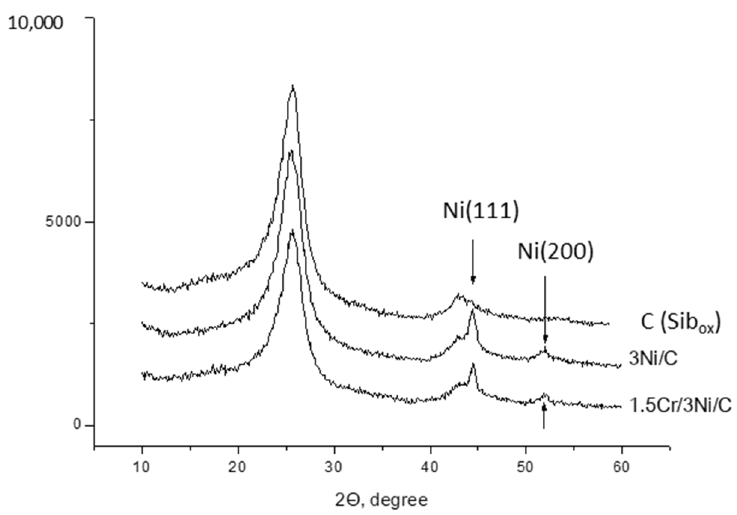
Figure 4. Diffractograms of the carbon carrier, 3Ni/C and 1.5Cr/3Ni/C catalysts.